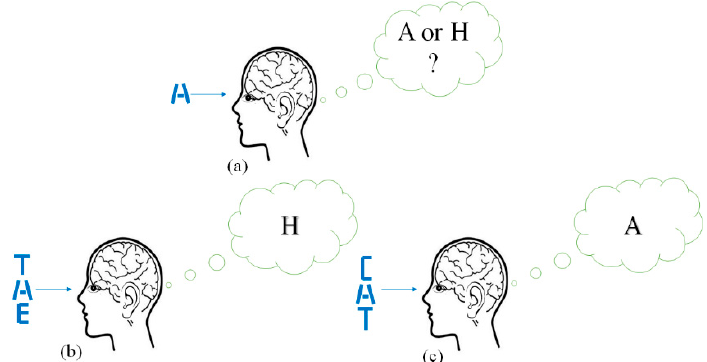
Figure 1. Interpreting an ambiguous letter ( a ) without context, ( b ) with context T and E, and ( c ) with context C and T.